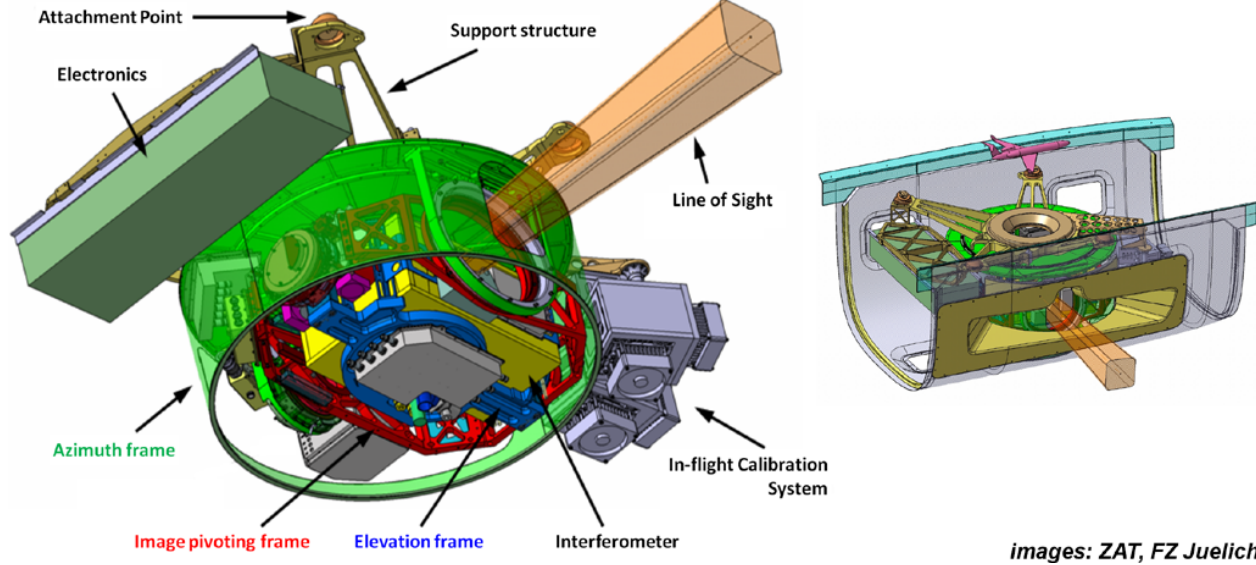
Fig. 2. Left: Gimbal-mounted GLORIA instrument with its in-flight calibration system; right: GLORIA in the belly pod of a research airplane.